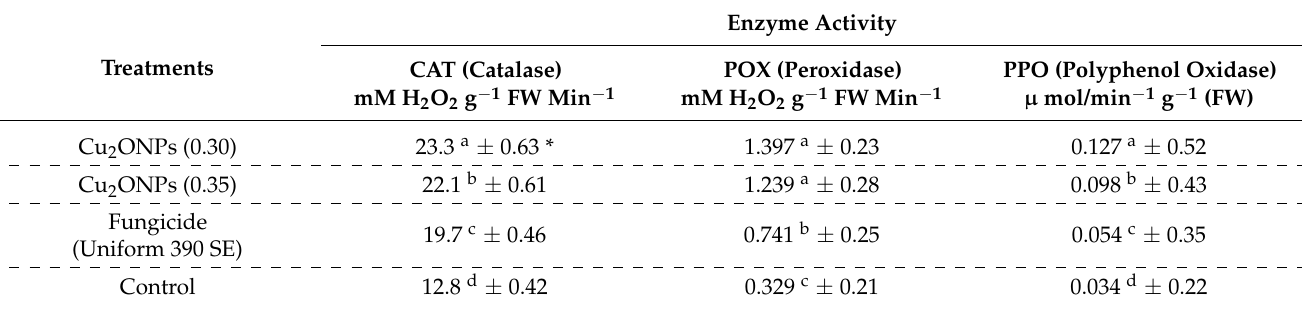
Table 4. Effect of Cu 2 ONPs compared to the chemical fungicide on enzyme activities in treated cucumber plants.